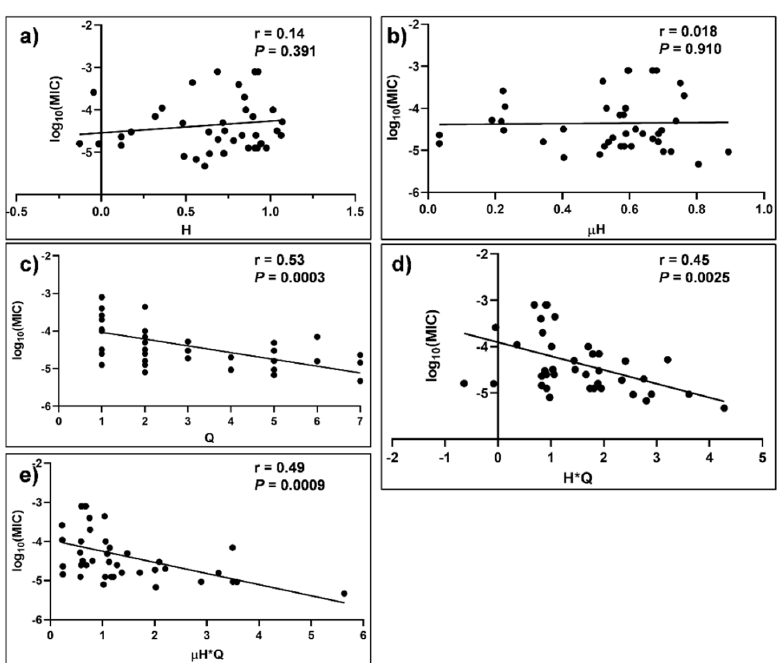
Figure 5. Dependence of MIC of α -helical peptides against C. glabrata and various physicochemical parameters. Spearman correlation analysis for MIC is plotted against ( a ) hydrophobicity (H); ( b ) hydrophobic moment ( μ H); ( c ) overall net charge (Q); ( d ) Hydrophobicity and charge (H*Q) and ( e ) Hydrophobic moment ( μ H*Q).